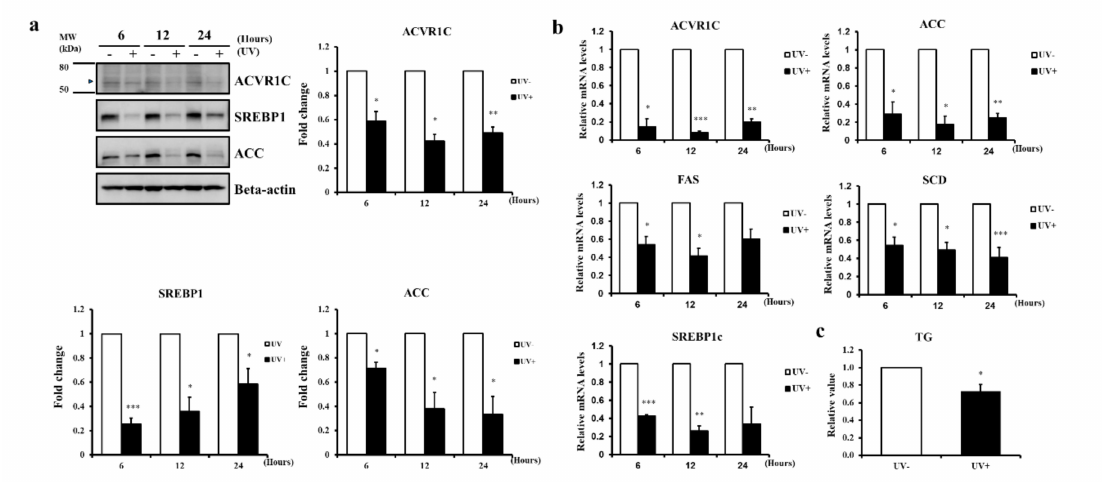
Figure 2. UV irradiation decreases the expression of ACVR1C as well as lipogenic genes in primary normal human epidermal keratinocytes (NHEK) . ( a ) Primary NHEK were irradiated with UV (75 mJ/cm 2 ) and the protein levels of ACVR1C, sterol regulatory element binding protein-1 (SREBP1), and acetyl CoA carboxylase (ACC) were measured by Western blotting. β -actin was used as a loading control (n = 3). ( b ) mRNA levels of ACVR1C and lipogenic genes, such as ACC, FAS, SCD, and SREBP1c , were measured by quantitative RT-PCR after UV irradiation. Data are presented as means ± SEM of the level of each gene relative to 36B4 (n = 3); ( c ) total lipids were extracted from primary NHEK with chloroform/methanol/water (1:2:0.8, v / v / v ). TG contents were measured by a fluorescent enzymatic method and normalized against the protein contents (n = 4). * p < 0.05, ** p < 0.01, *** p < 0.001 vs. the non-irradiated